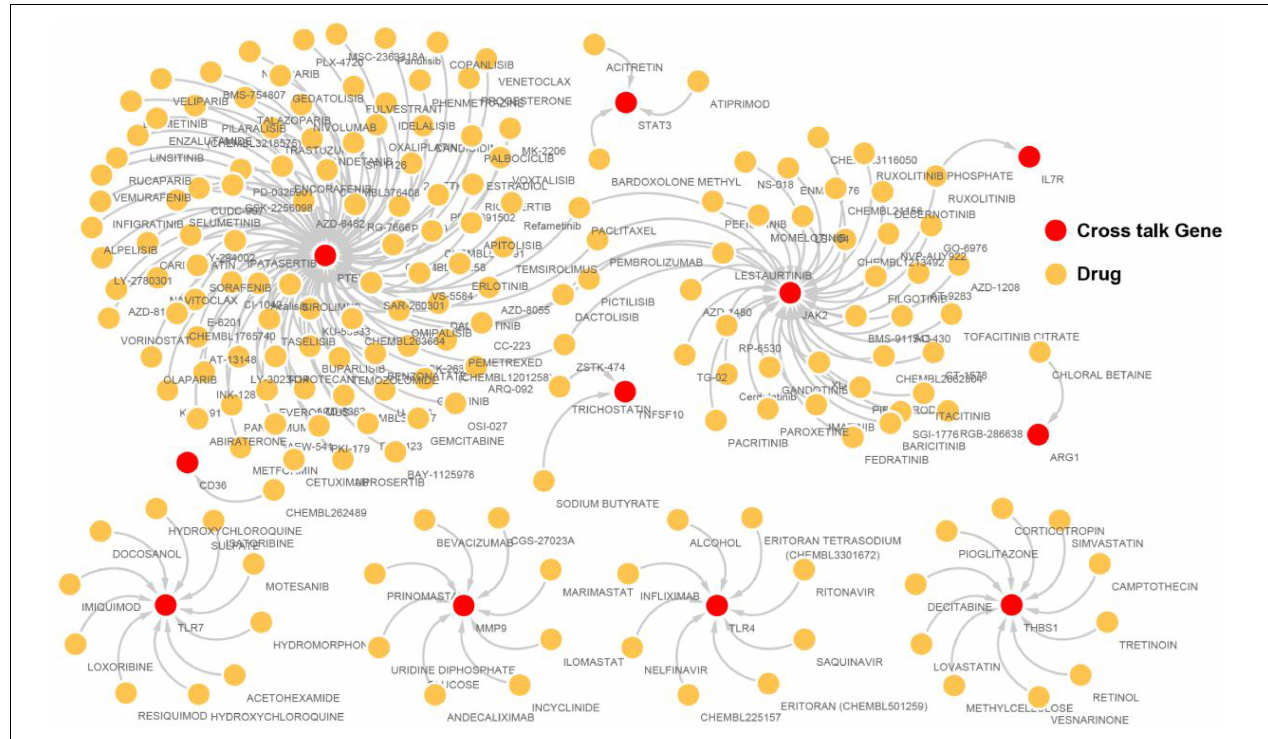
FIGURE 12 | The immunosuppression-related crosstalk genes-target drugs